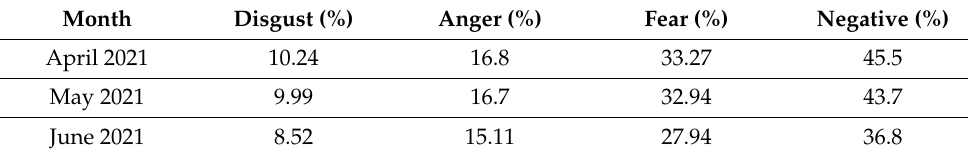
Table 1. Monthly hatred-influencing emotions.